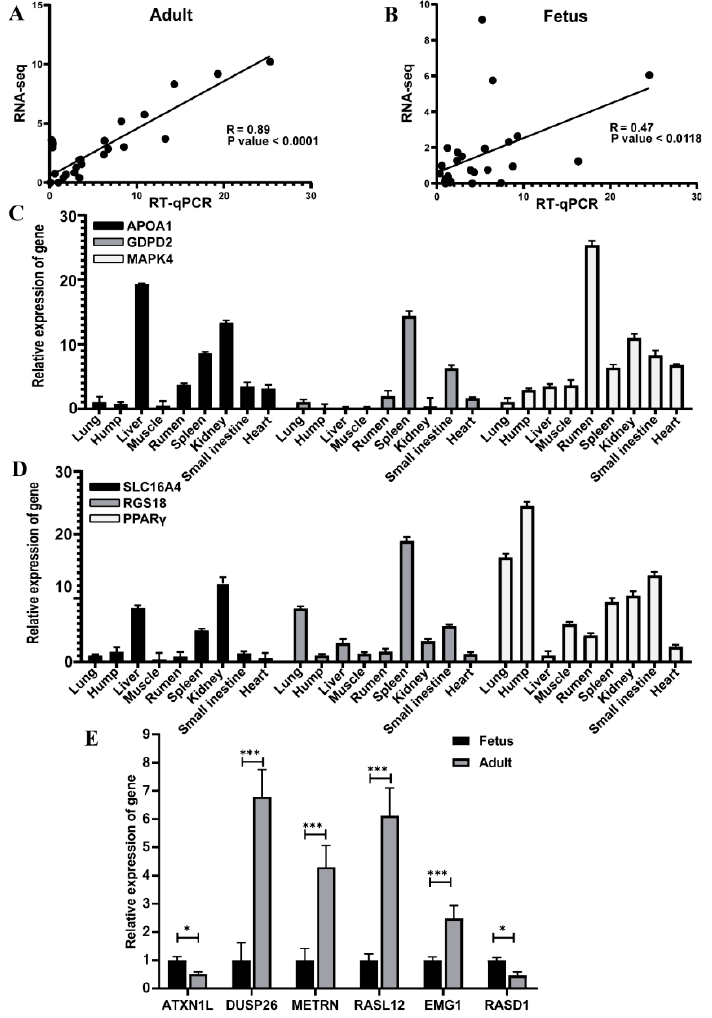
Figure 4. Validation of RNA-Seq results by quantitative real-time polymerase chain reaction (qRT- PCR) across different tissues of Bactrian camels. Concordance between qRT-PCR and RNA-seq results in ( A ) adults and ( B ) fetuses. Correlation analysis was performed using GraphPad software version 8.0. ( C ) Relative mRNA expression of hub genes APOA1 , GDPD2 , and MAPK4 in adult tissues. ( D ) Relative mRNA expression of hub genes SLC16A4 , RGS18 , and PPAR γ in fetal tissues. ( E ) RT-qPCR analysis of differentially expressed genes in the rumen (* p < 0.05; *** p <